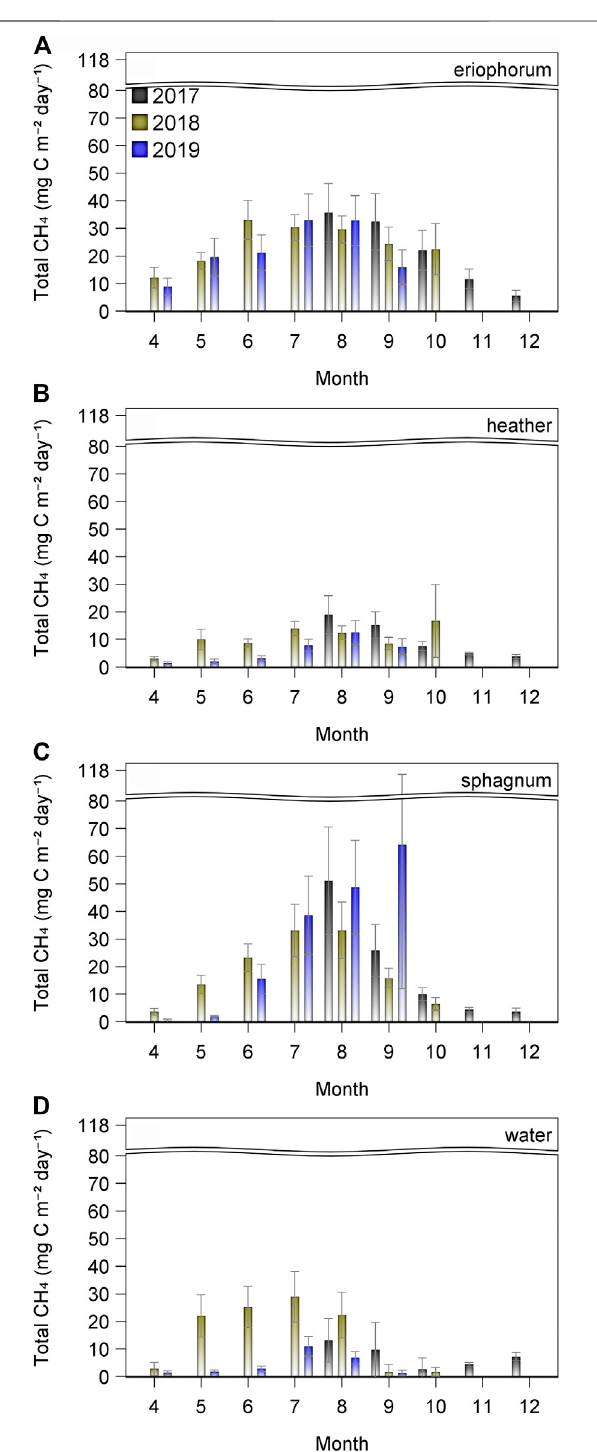
FIGURE 6 | Total monthly fl ux of CH 4 from each ecotype (n (cid:2) 6, ± 1SE) for 2017 (black), 2018 (olive) and 2019 (blue).